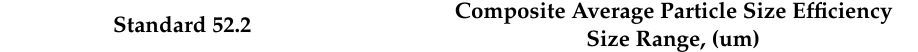
Table 9. Minimum Efficiency Reporting Value (MERV)